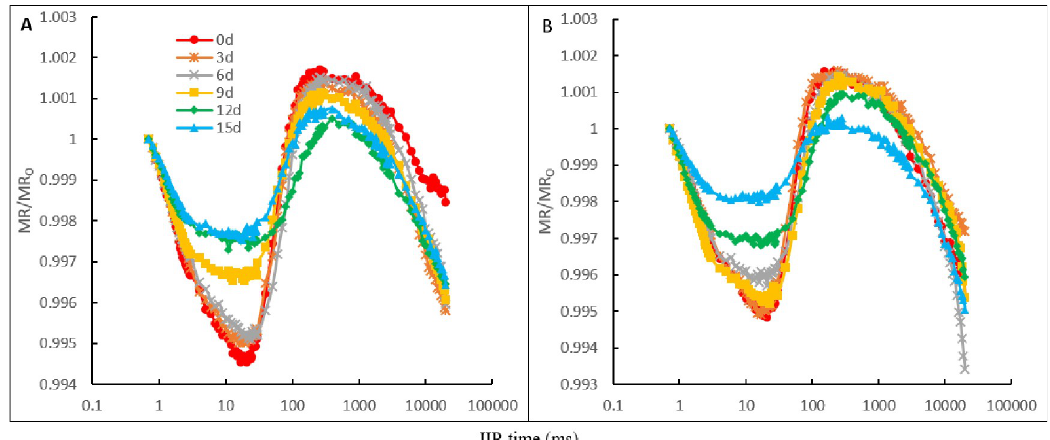
Fig 6. The modulated 820-nm reflection kinetics (MR/MR O ) of oat leaves in NaCl treatment and NaCl treatment with CaCl 2 amendment on the day of NaCl stress and on days 3, 6, 9, 12, and 15 of NaCl stress. (A)The MR/MR O curves in the NaCl treatment. (B) The MR/MR O curves in NaCl treatment added CaCl 2 . The signals were plotted on a logarithmic time scale (JIP Time). Each value of the curves is the average of 3